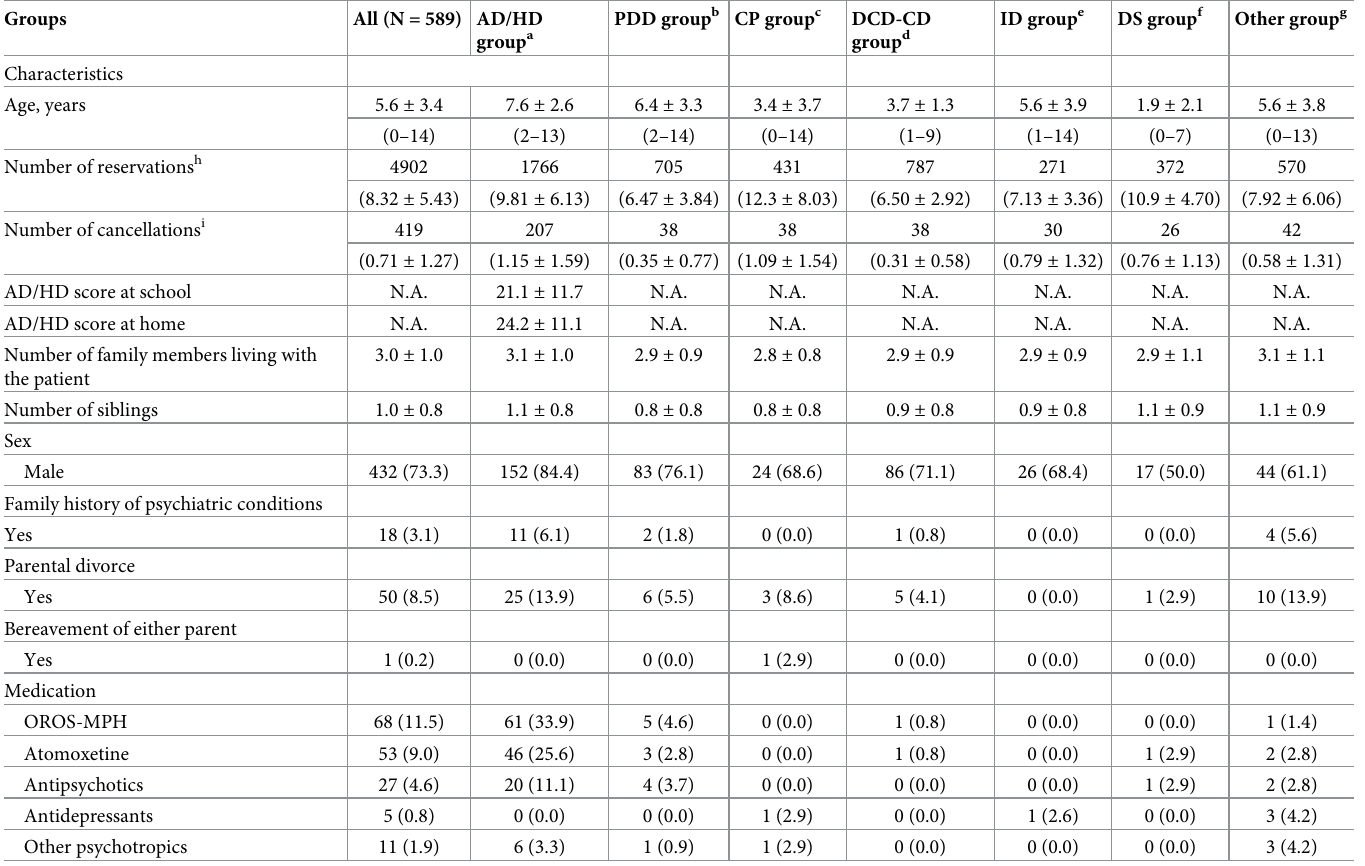
Table 1. Demographic and clinical characteristics of the patients included in the